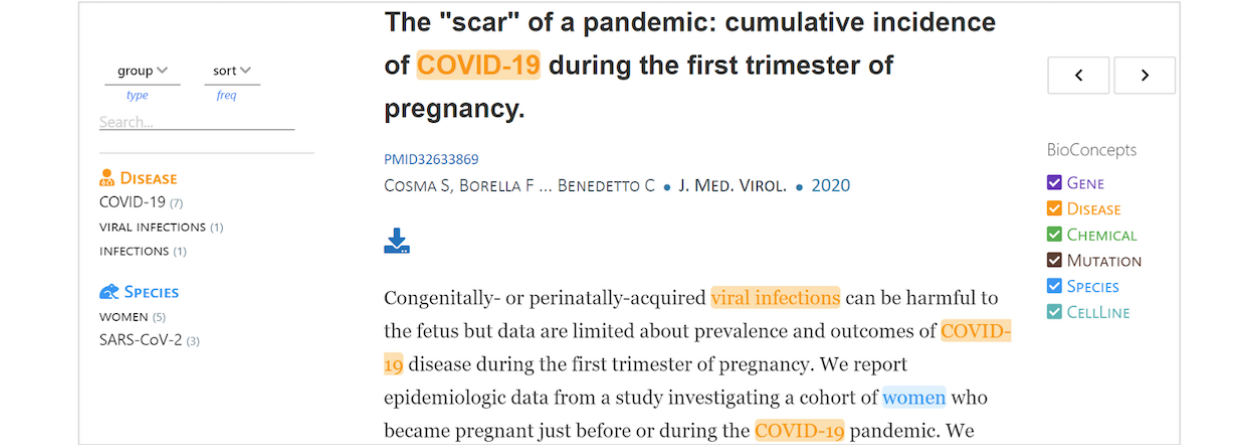
Figure 8. Annotated entity types highlighted in different colors in the title and